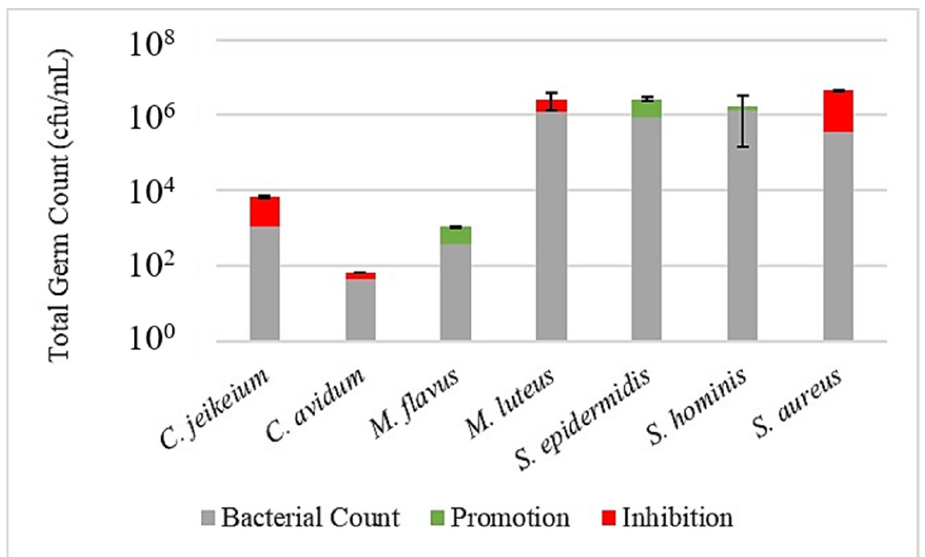
Figure 3. Total germ count of C. jeikeium , C. avidum , M. flavus , M. luteus , S. epidermidis , S. hominis and S. aureus with the indication of promotion and inhibition of 10 μ L serum without actives (serum control). Grey bars represent the bacterial count of the untreated control, while red or green areas indicate inhibition or promotion by the serum treatment, respectively. All measurements have been performed in duplicates. No significant differences could be detected using Student’s t -test ( p < 0.1).